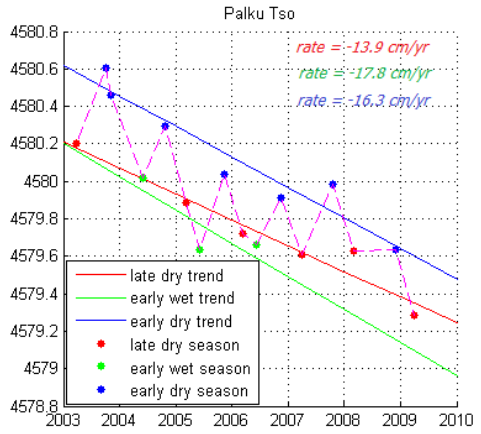
Figure 2. Seasonal water level trends for Palku Tso Lake between 2003 and